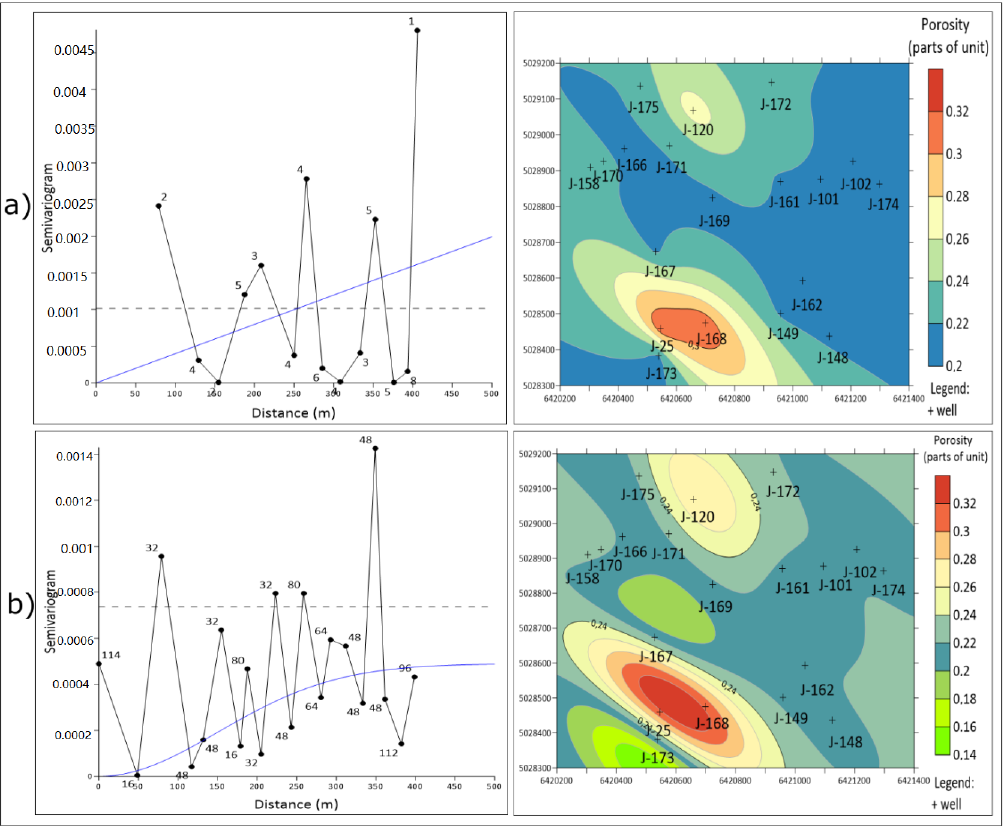
Figure 4. Experimental semivariograms and porosity maps for the “K” reservoir obtained by the ordinary kriging (OK) method: ( a ) without the “jack-knifed” method and ( b ) with the “jack-knifed” method